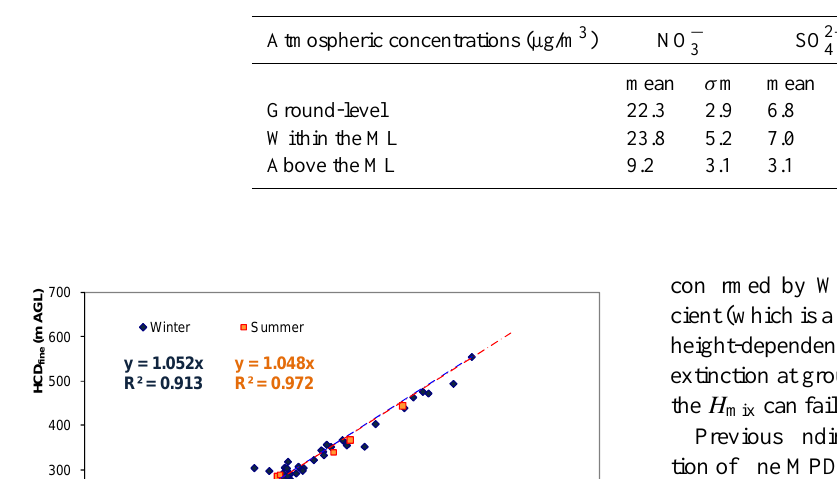
Table 3. Mean atmospheric concentrations for NO − mixing layer are normalized to ground pressure and temperature; σ m = mean standard deviation.